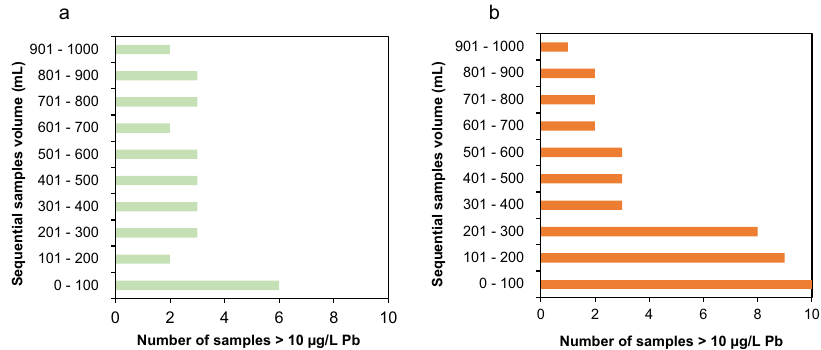
Fig. 3 Distribution of sequential samples exceeding 10 μ g/L Pb. Number of sequential samples exceeding 10 μ g/L Pb in the building with the largest proportion of unsafe samples. 0 – 100 mL refers to the fi rst 100 mL collected. a Dispenser ( n = 90) and b faucet ( n = 100).